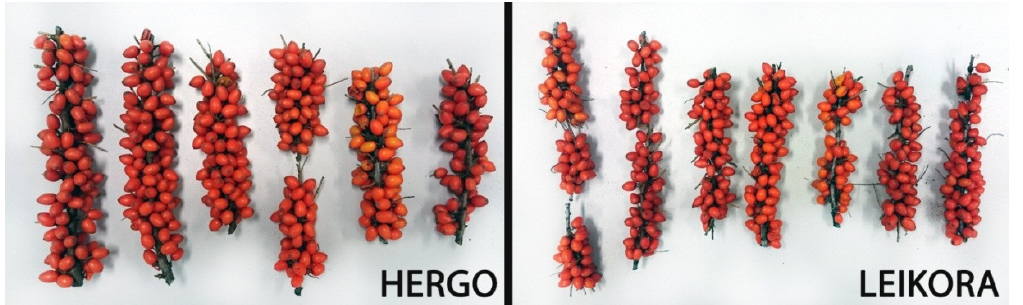
Figure 2. Evaluated varieties of sea buckthorn ( Hyppophae rhamnoides ) .